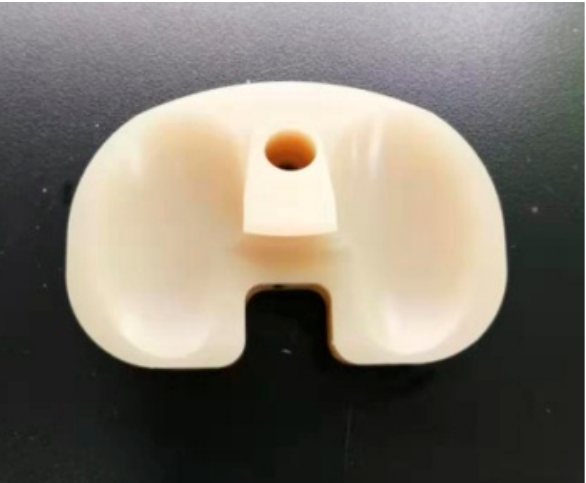
Figure 1. HXLPE-DG tibial insert.